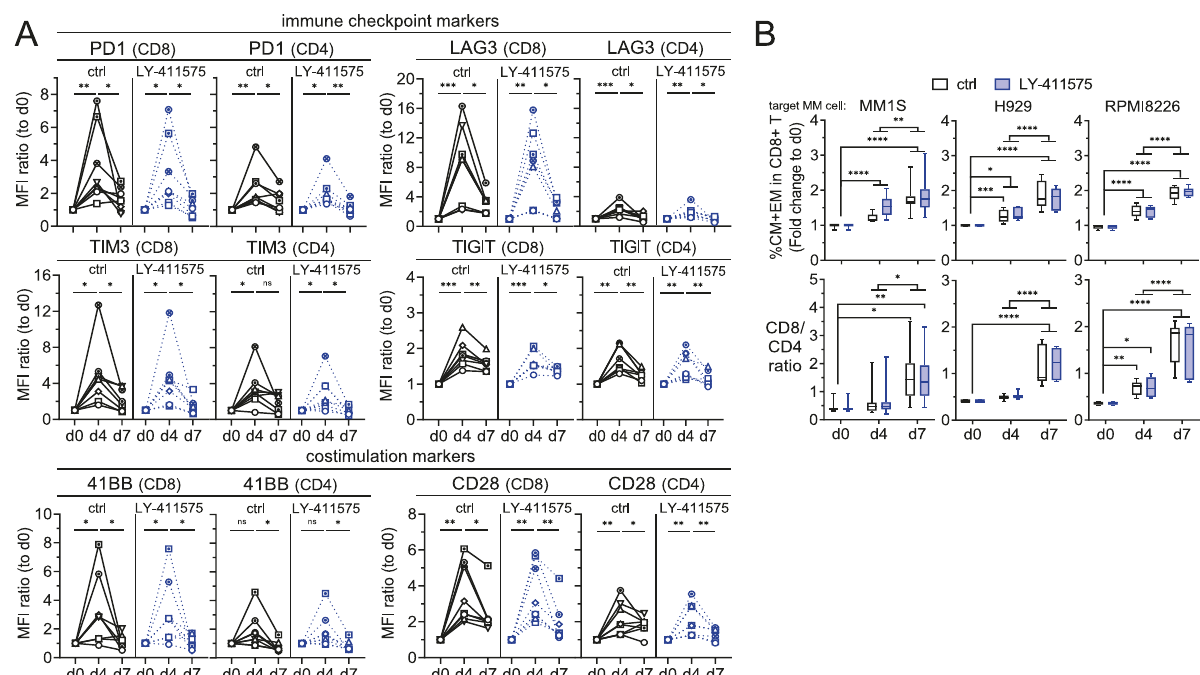
Fig. 6 LY-411575 minimally affected PL33-induced transient expression of checkpoint and co-stimulatory markers, as well as time- dependent increases in memory cell differentiation and CD8/CD4 ratios in patient T cells in longer 7 day-co-cultures. A Mixtures of patient T cells ( n = 8) with target MM1S cells (E:T = 1:1) were treated with 1 nM PL33 in control (ctrl, black) or LY-411575 (2 nM, blue)-containing media on day 0 (d0). In 7 day time course expression studies, quantitative FC analysis was used to determine serial changes of immune checkpoint markers (PD1, TIM3, LAG3, TIGIT) and co-stimulatory markers (4-1BB, CD28) on CD8 (left in each marker panel) and CD4 (right in each marker panel) T cells. Shown is the relative expression of each marker by MFI ratios, which was normalized to the MFI values of ctrl groups on d0. The serial changes of each marker were analyzed by Wilcoxon matched pairs signed rank test. Different symbols represent T cells from different individuals. B Indicated MM target cells ( n = 3) were co-cultured with patient T cells for 7 day ( n = 8 – 11) in the presence of 1 nM PL33, in ctrl or LY-411575-containing media. Shown are % central memory (CM, CD45RA − CD62L + ) and % EM (CD45RA − CD62L − ), as well as CD8/CD4 ratios. Eight to 11 independent experiments were done in triplicates at each time point. * P < 0.05; ** P < 0.01; *** P < 0.001; **** P < 0.0001; ns, not signi fi